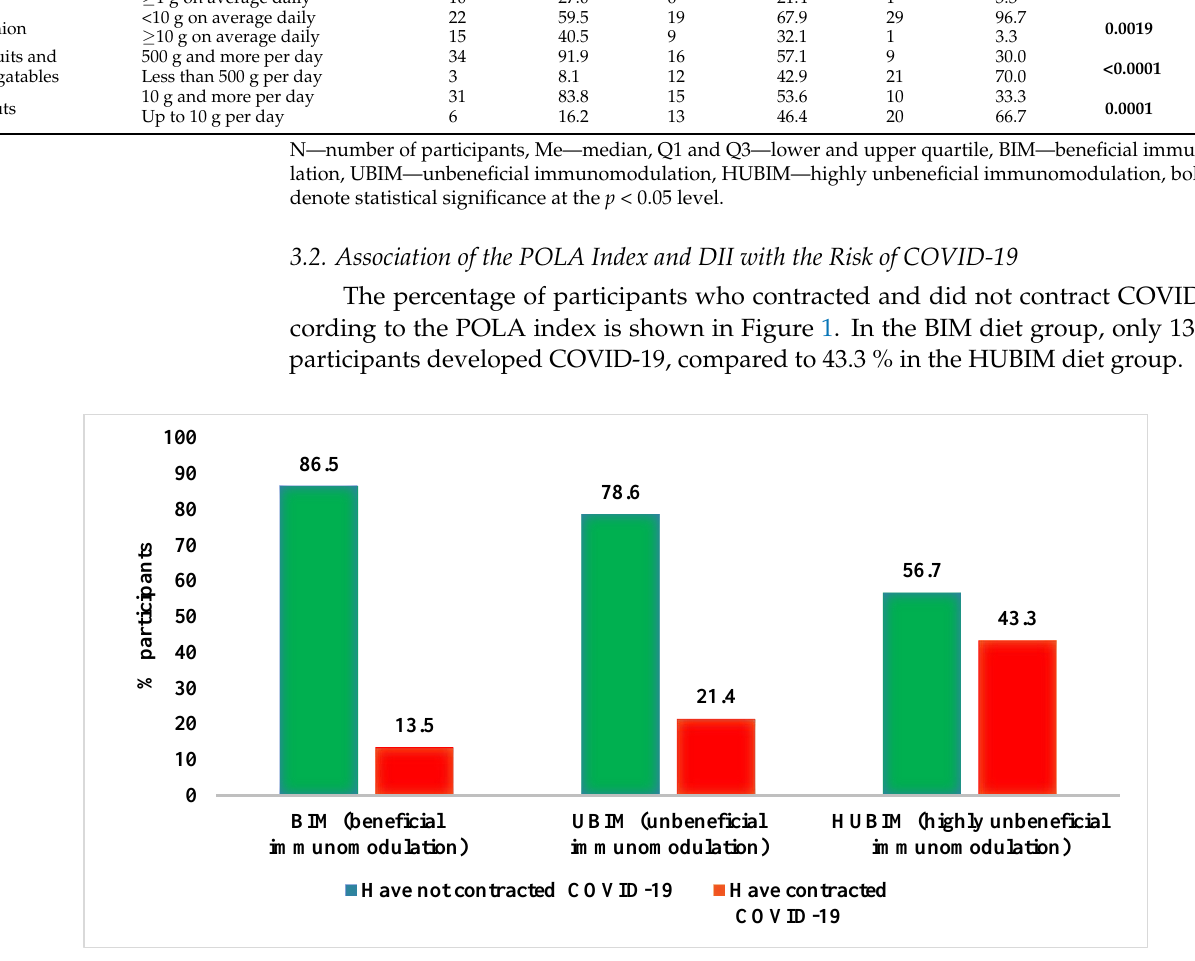
Figure 1. Incidence of COVID-19 according to the POLA index. The percentage of participants who contracted and did not contract COVID-19 ac- cording to DII tertiles is shown in Figure 2.